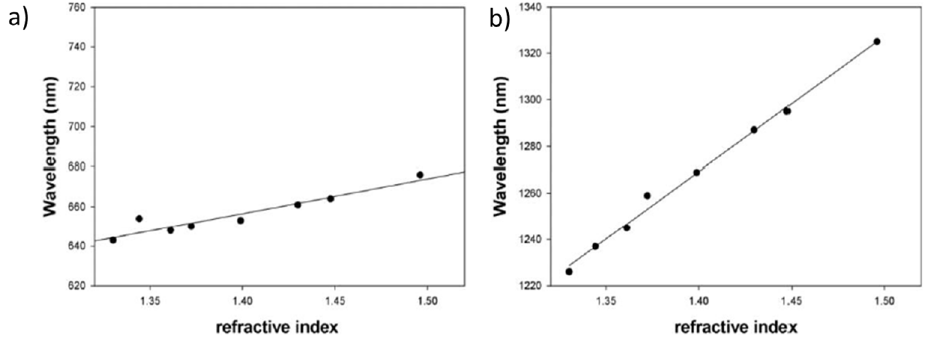
Figure 4. Wavelength shift of LSPR2 ( a ) and LSPR3 ( b ) when the GNS are suspended in different solvents with refractive index values from 1.3300 up to 1.4476. Reprinted with permission of [7].